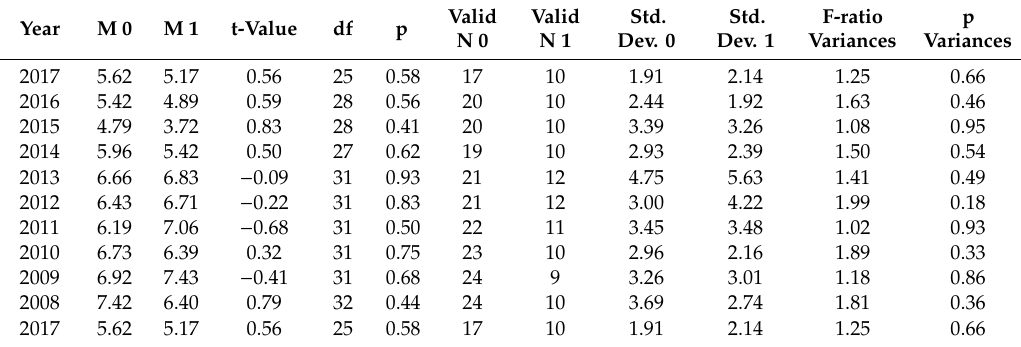
Table 6. Student’s t-test results for Altman model values,